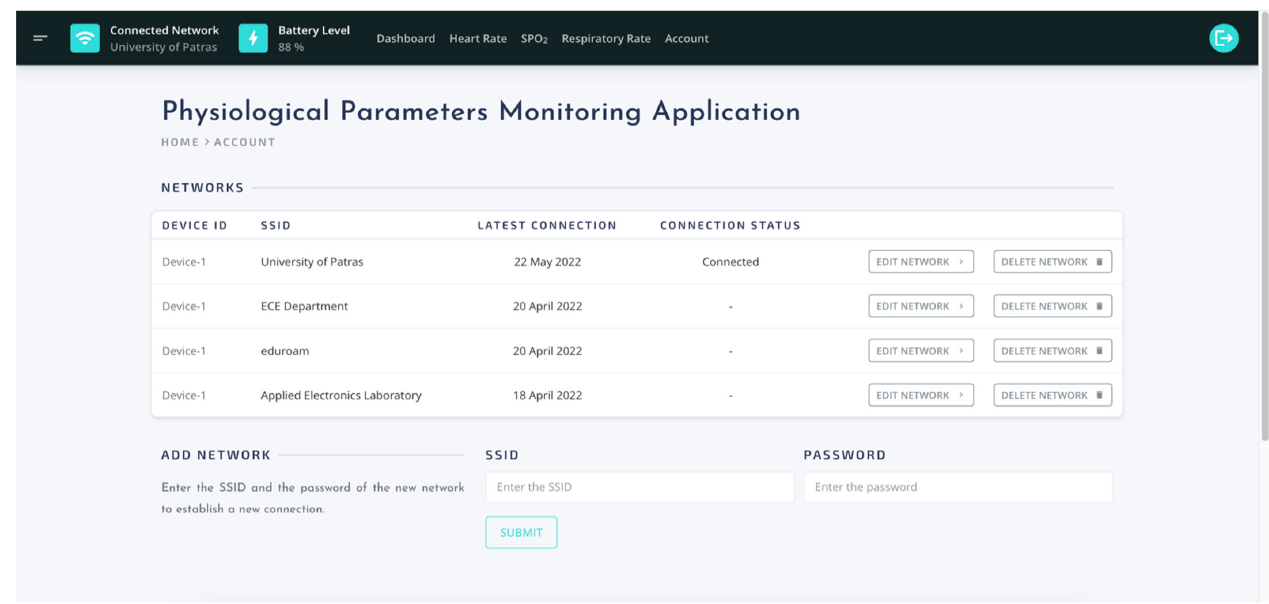
Figure 12. The UI of heart rate analytics.